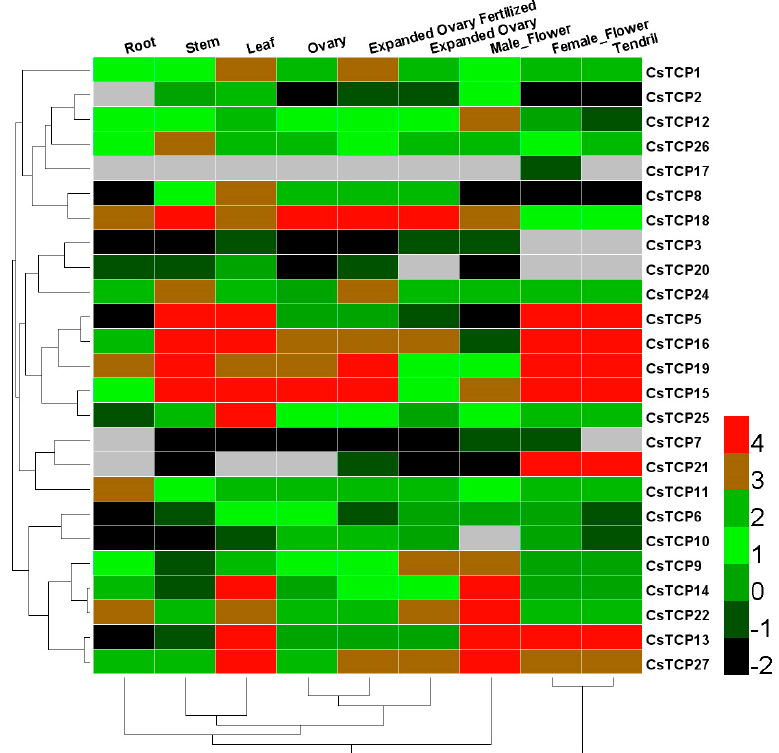
Figure 2. Tissue-specific expression of CsTCP genes in cucumber. The CsTCP genes transcripts in nine tissues of cucumber 9930 were determined by public transcriptome data. The color scale showed that the increasing expression levels form black to red.